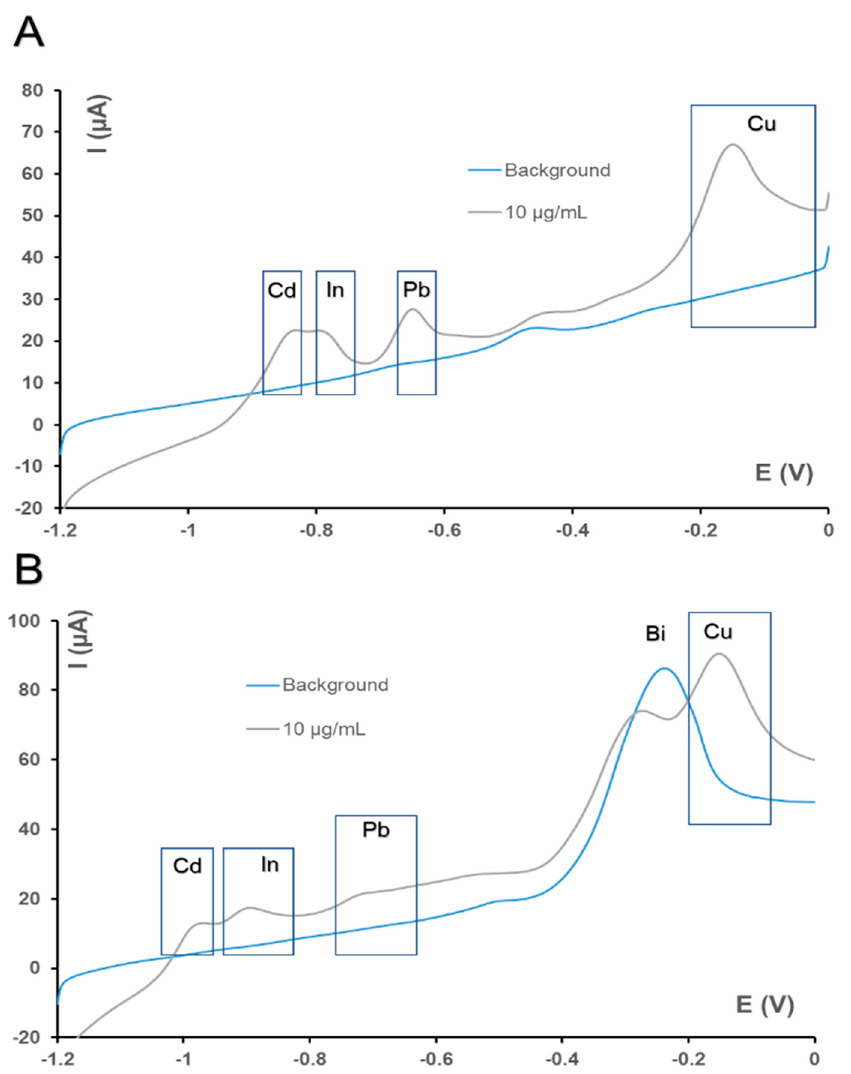
Figure 2. Linear sweep voltammograms for Pb (II), Cd (II), Cu (II) and In (III) (10 µg/mL) solutions recorded in paper-based electrodes modified with ( A ) mercury or ( B ) bismuth films. Preconcentration step: E d = − 1.2 V, t d = 600 s). Stripping step: E i = − 1.2 V, E f = 0 V, E s = 2 mV, v = 50 mV/s).